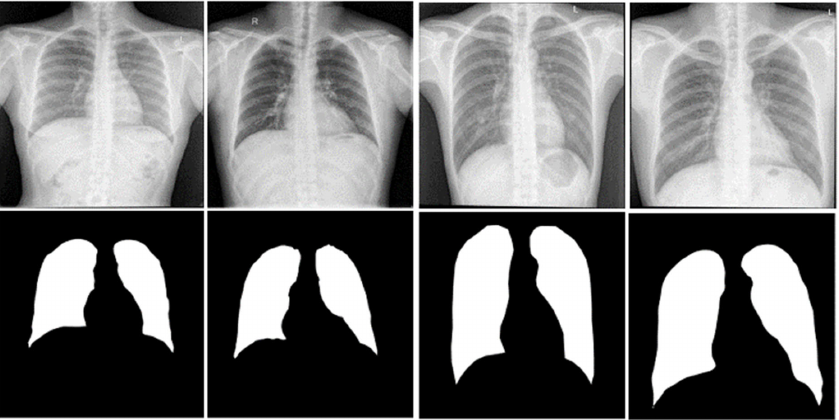
Figure 2. Sample CXR images (top row) and their ground truth masks (bottom